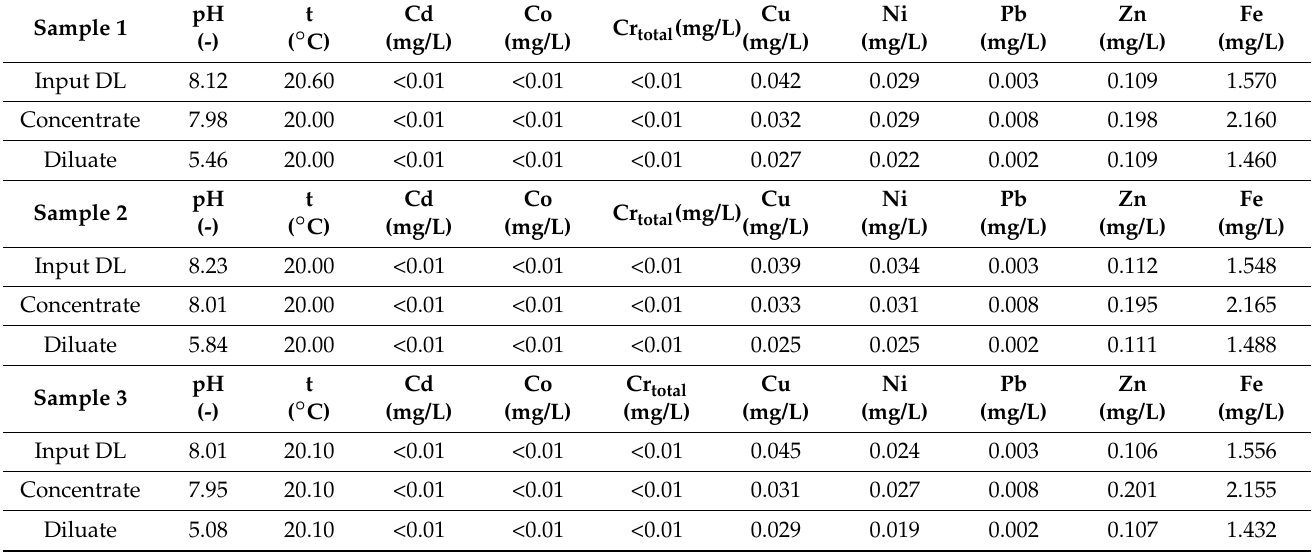
Table 5. Values of heavy metals in ED products of samples 1–3.